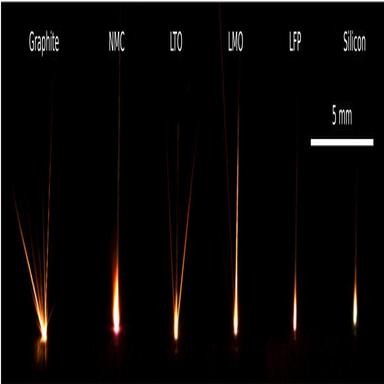
Photographs of ablation plumes for each material studied in this work.